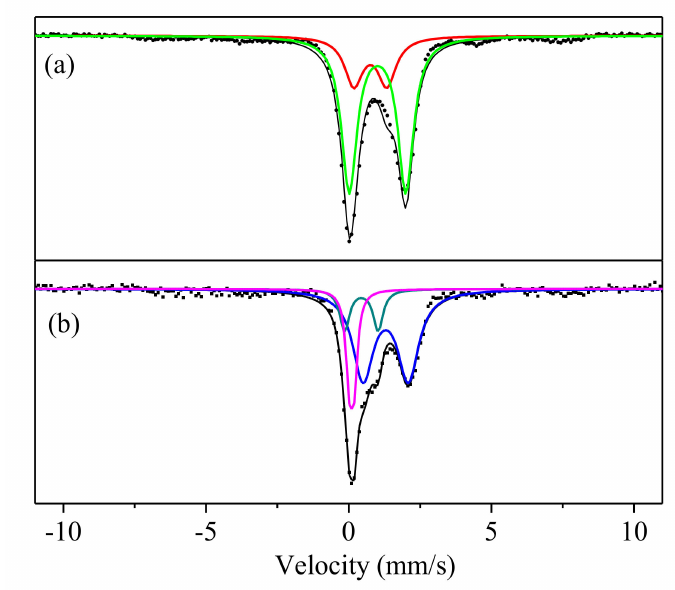
Figure 7. Mössbauer spectrums of the initial LSS ( a ) and LSS based geopolymer (R 2 ) after being hydrated for 28 days ( b ).